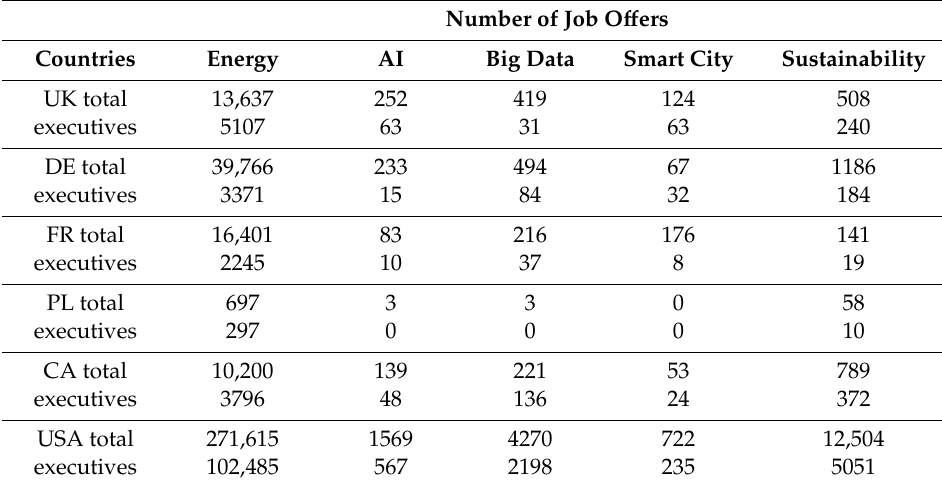
Table 1. The results of information acquisition using the “Indeed”